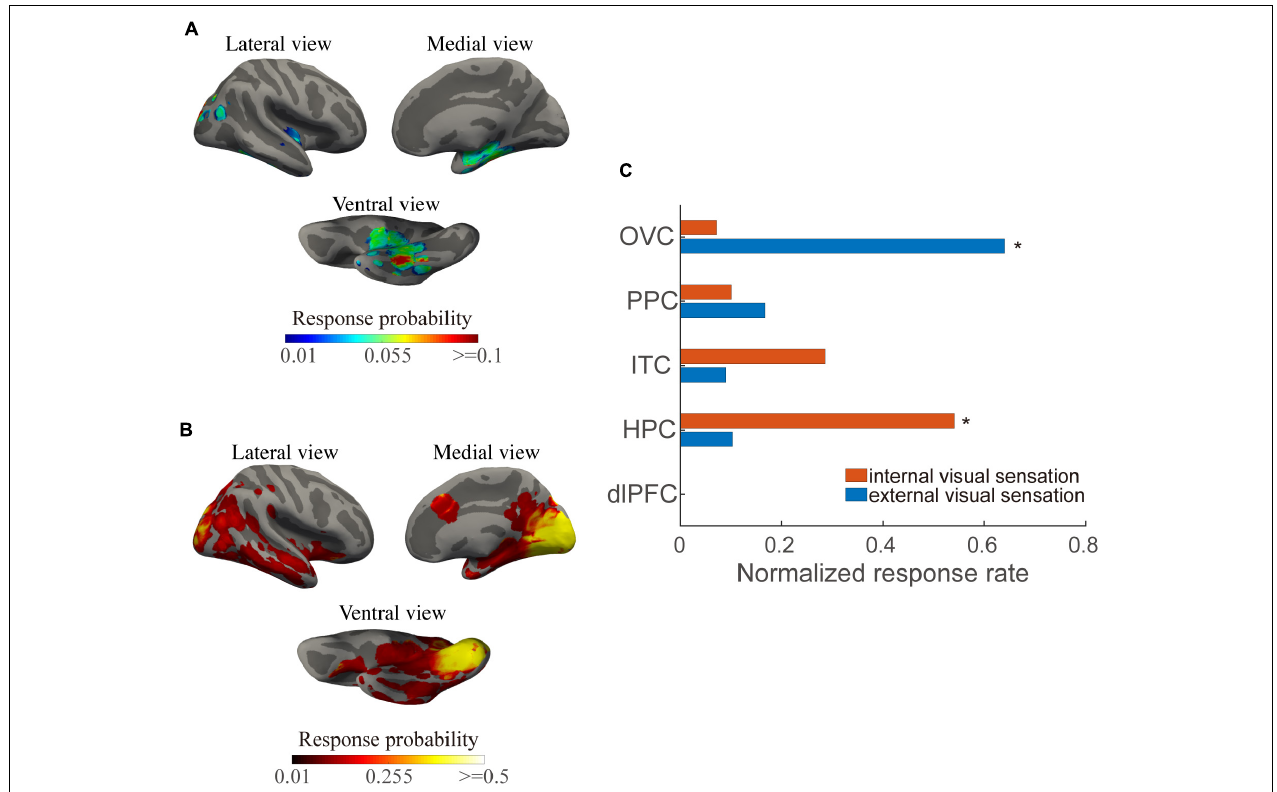
FIGURE 2 | Internal and external visual sensation probability across the cortical surfaces and structural modules. (A) Mean response probability for internal visual sensations across the cortical surfaces. (B) Mean response probability for external visual sensations across the cortical surface. (C) Normalized response percentage, normalized across modules, for each visual response type. Asterisks indicate regions in which the individual chi-square value exceeds a significant level ( p < 0.01, Bonferroni correction for multiple